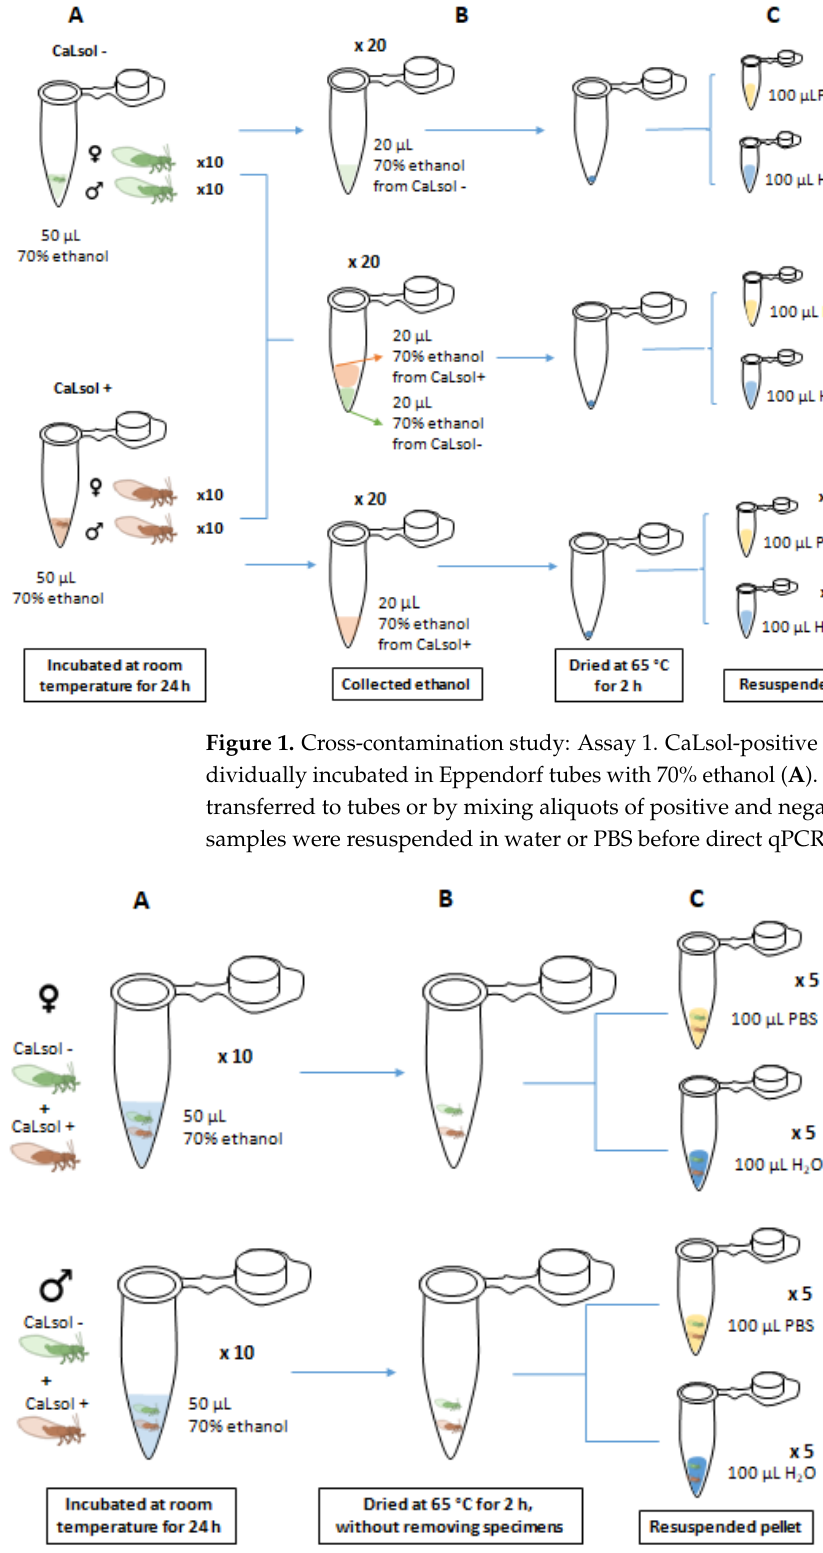
Figure 2. Cross-contamination study: Assay 2. Couples of same sex psyllids, one CaLsol-positive and one CaLsol-free, were incubated in ethanol ( A ). Ethanol was dried without removing the specimens ( B ). The samples were resuspended in water or PBS before direct qPCR analysis ( C ). ♀: female; ♂: male.